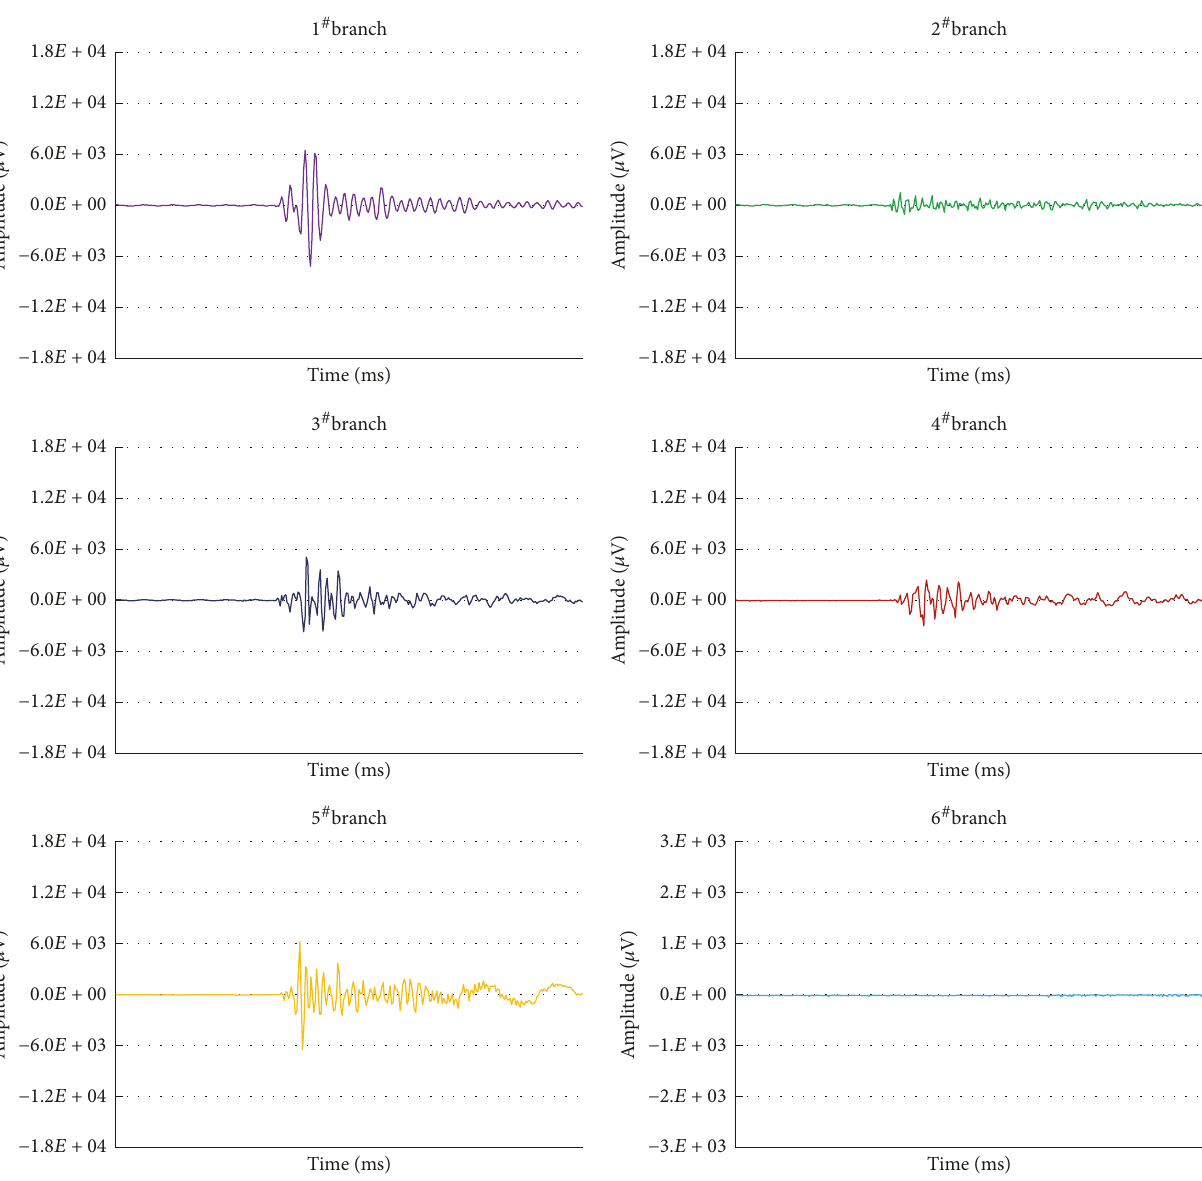
0.809y = 15133e −0.05x R 2 =